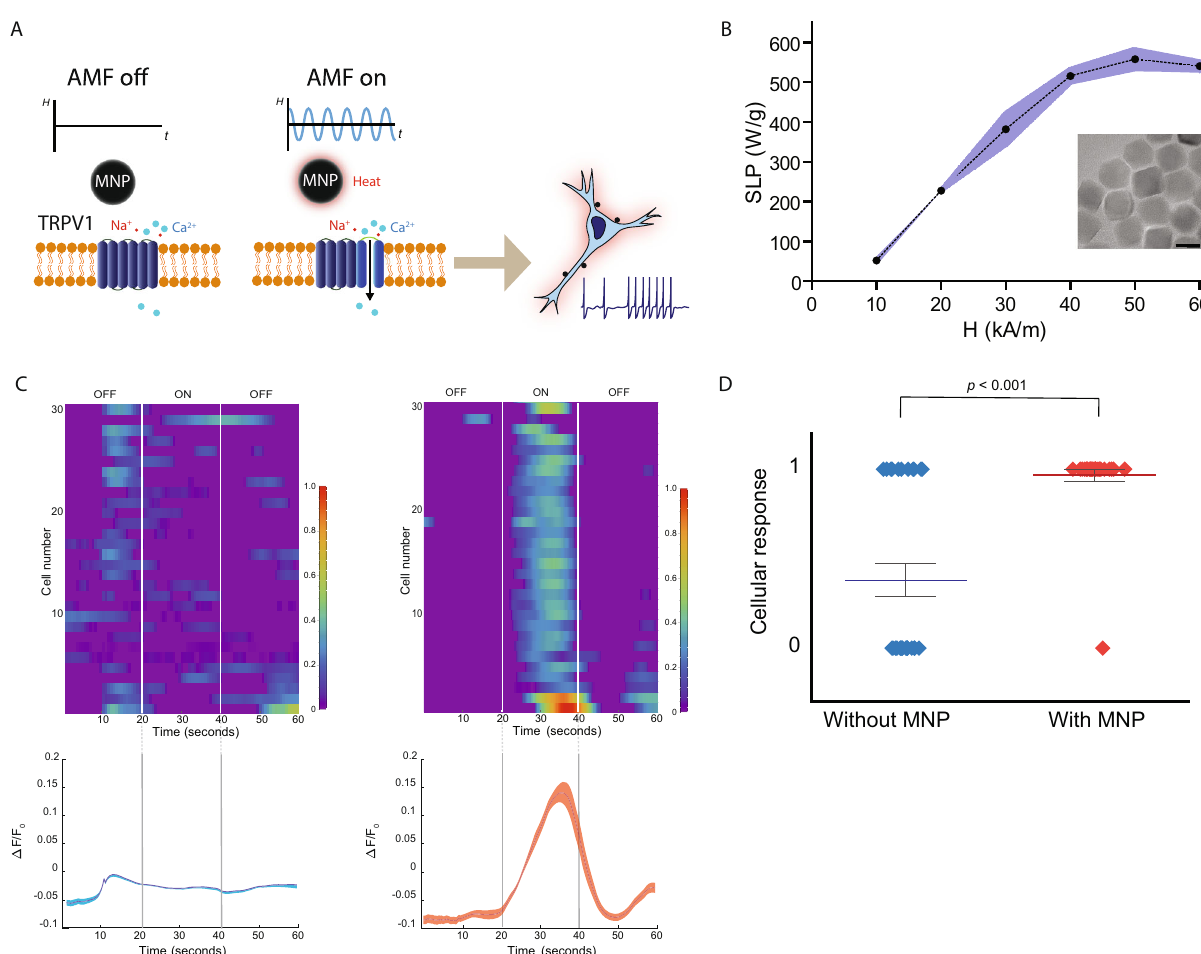
Fig. 1 In vitro magnetothermal control. A Experimental scheme. Magnetic fi eld stimulation ( “ AMF ON ” ) induces MNP heating and thereby membrane depolarization. B Speci fi c loss power (SLP, normalized to iron content [Fe]) measurements at 160 kHz and different fi eld amplitudes. The SLP was calculated from the rate of temperature increase of a 1 mg/ml [Fe] sample. Data presented as mean ± S.D., n = 3 independent experiments for each fi eld amplitude. Transmission electron micrograph of MNPs, scale bar is 20 nm. C Heatmaps of fl uorescence intensity changes recorded from GCaMP6s transients observed in TRPV1-expressing HEK293FT cells during magnetic fi eld stimulus with and without MNPs (for each condition n = 30